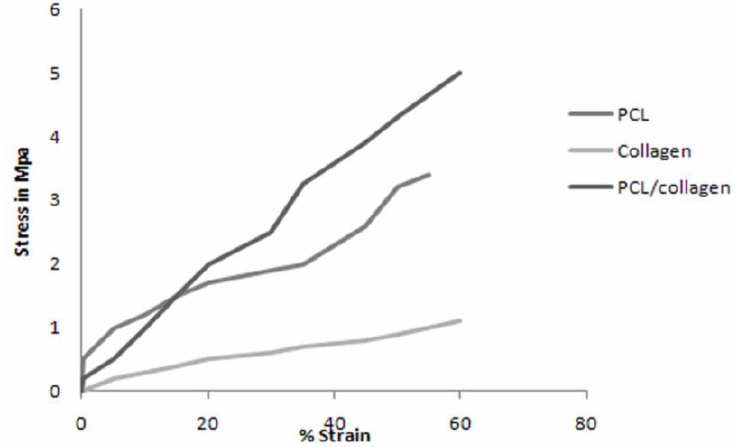
Figure 2. Stress-strain curve of electrospun PCL, collagen, and PCL/collagen nanofibrous scaffolds. The PCL scaffolds reached a maximum tensile strength of 3.50 MPa with an ultimate strain of 54%, the collagen scaffolds reached a maximum 1.30 MPa, but with an elongation at break of 61%, and the biocomposite PCL/collagen scaffolds had the highest tensile strength, 5.00 MPa, with a 60% elongation at